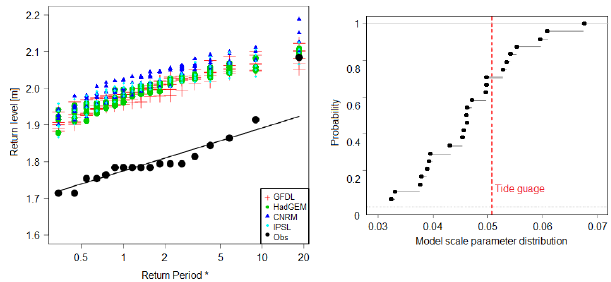
Figure 6. (a) Empirical return level data of extreme water level based on 18 years of tide gauge data from Raffles Light House (1996–2013), and 18-year long samples from the model simulations at grid point “a”. The fitted Gumbel distribution of the observations is shown by the straight line. (b) Empirical cumulative density func- tion of the scale parameters of the model samples, showing that the scale parameter of the tide gauge data sits well within the model distribution. Table 4. Projected century-scale trends in skew surge for five re- turn periods (excluding mean sea level change). Units aremm per century.